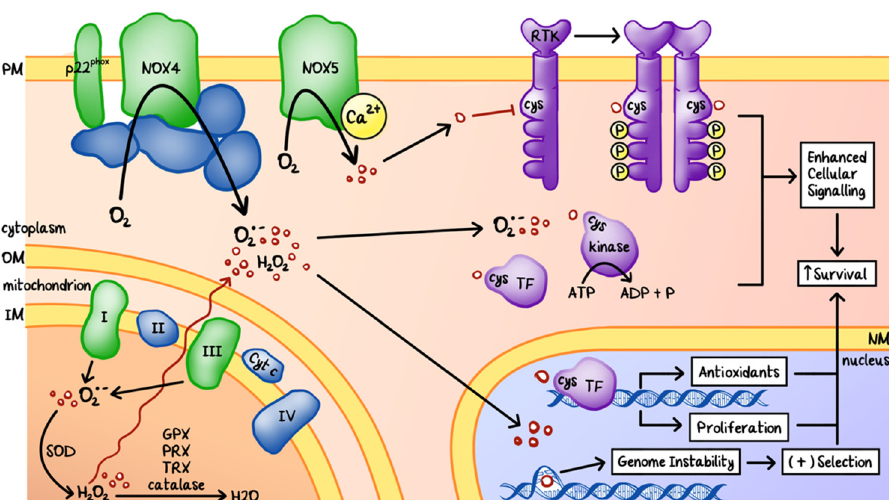
Figure 2. Origins and effects of cellular reactive oxygen species (ROS). ROS are generated by complex I and III of the electron transport chain in the mitochondria and by NADPH oxidase (NOX) enzymes located at the cytoplasmic membrane (PM). ROS disrupt cellular processes by oxidizing the cysteine (Cys) residues of various proteins and damaging nucleic acids. Oxidation by ROS could cause the inactivation of phosphatases, activation of kinases and transcription factors (TF), and genomic alterations, leading to enhanced cellular proliferation and survival. ROS production is counteracted by the generation of antioxidants, such as superoxide dismutase (SOD), glutathione peroxidase (GPX), peroxiredoxin (PRX), thioredoxin (TRX), and catalase. In cancers, redox homeostasis is modified to favor ROS tolerance. OM: outer mitochondrial membrane. IM: inner mitochondrial membrane. NM: nuclear membrane.